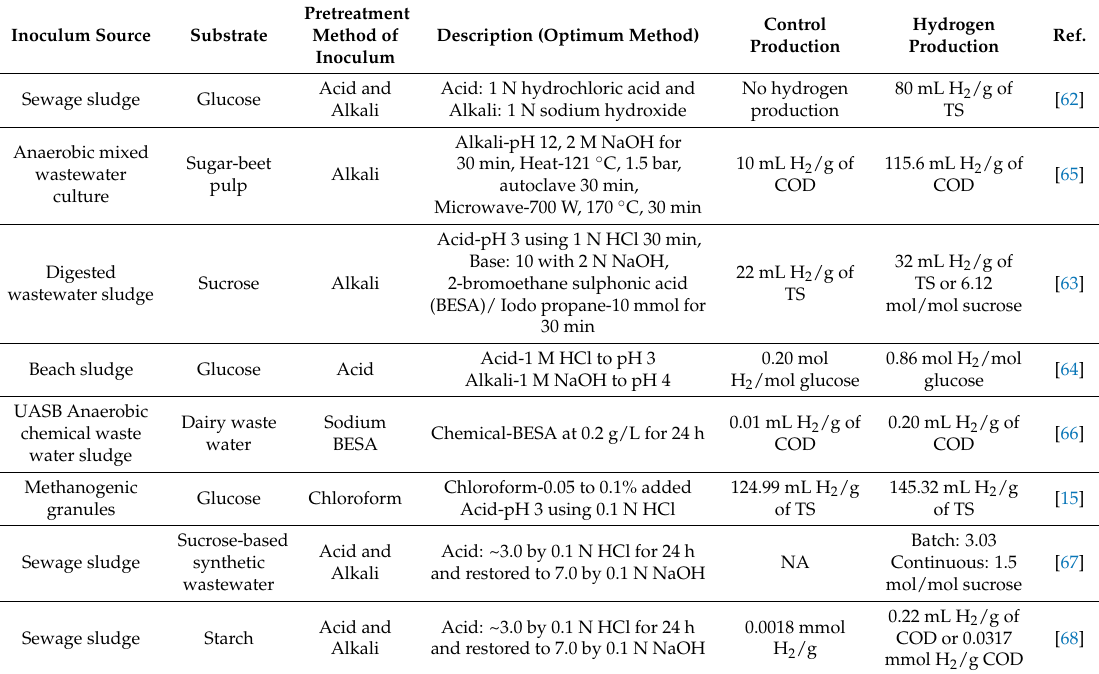
Table 2. Hydrogen yield by mixed culture using chemical